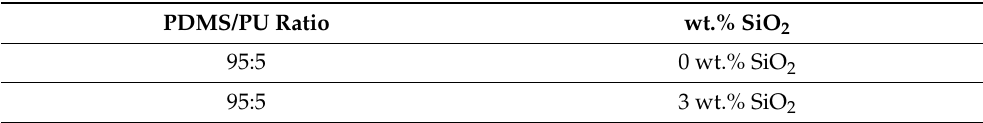
Table 1. The formulation of PDMS/PU with SiO 2